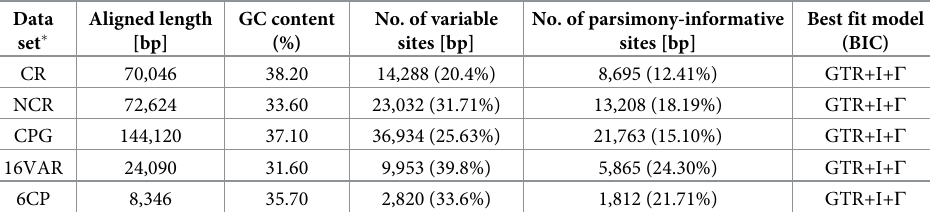
� : CPG, complete plastome sequences; CR, coding regions; NCR, non-coding regions; 16VAR: 16 hyper-variable regions; 6CP: six commonly cpDNA